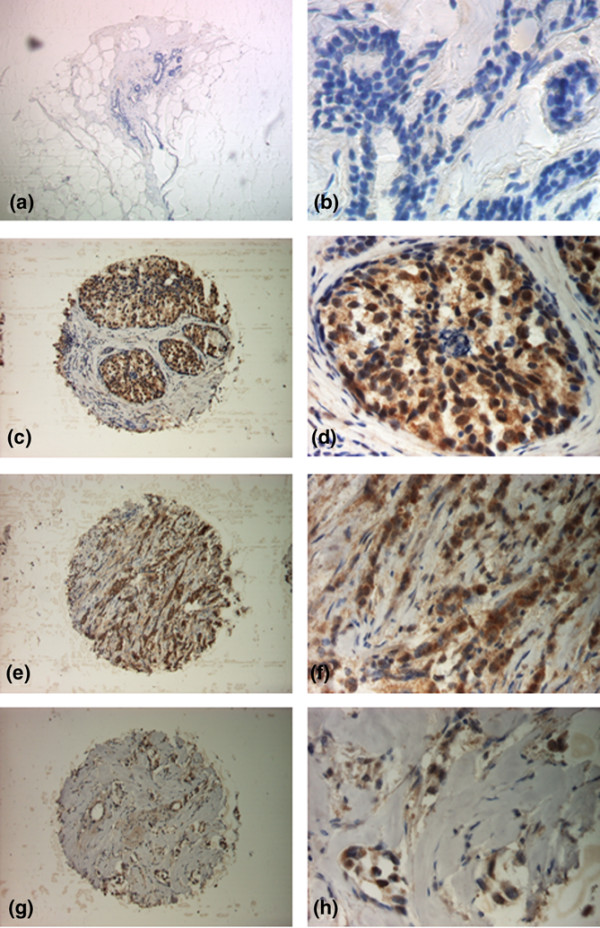
Immunohistochemical expression of ISG15 in normal breast tissue, and in non-invasive and invasive breast tumours using a tissue microarray. (a, b) Normal breast tissue lacks ISG15 expression (IRS = 0). (c, d) In ductal carcinoma in situ ISG15 expression is more intense (IRS = 8) than in normal breast tissue. (e, f) In invasive breast carcinomas (here: ductal type) ISG15 expression was clearly more abundant (example shows staining with an IRS = 12) compared with normal breast tissue and ductal carcinoma in situ. (g, h) In tubular breast carcinomas (IRS = 4), a less frequent variant of invasive breast carcinomas with a more favourable prognosis than invasive ductal breast carcinomas, ISG15 expression was less abundant than in most invasive ductal breast carcinomas and stronger than in most normal breast tissues. Magnifications: a, c, e, g: 100×; b, d, f, h: 400×.